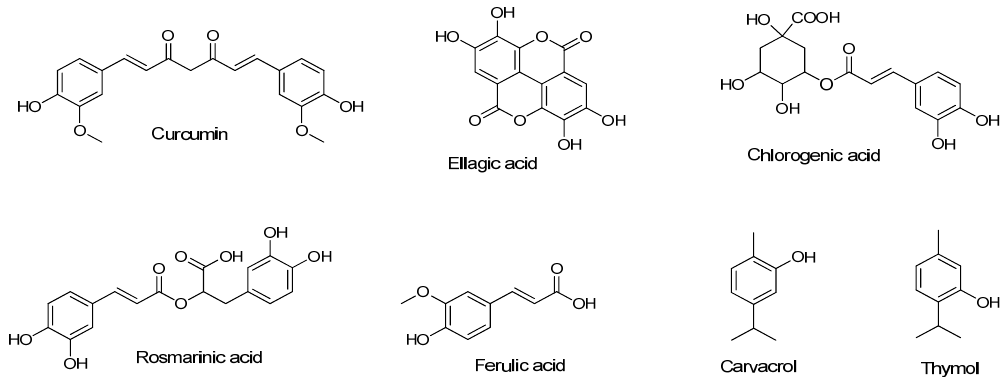
Figure 4. Chemical structures of selected phenolic compounds mentioned throughout this review.